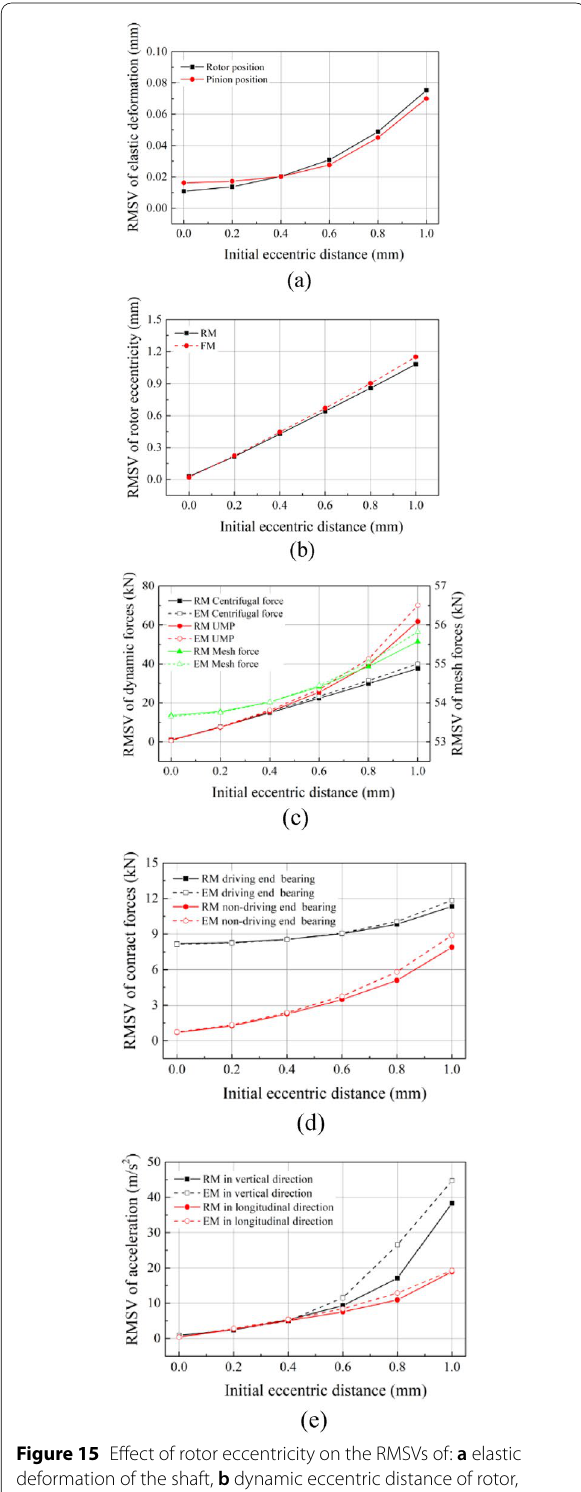
Figure 15 Effect of rotor eccentricity on the RMSVs of: a elastic deformation of the shaft, b dynamic eccentric distance of rotor, c internal dynamic forces of traction motor and mesh force, d roller-race contact forces of motor bearings, and e vibration accelerations of